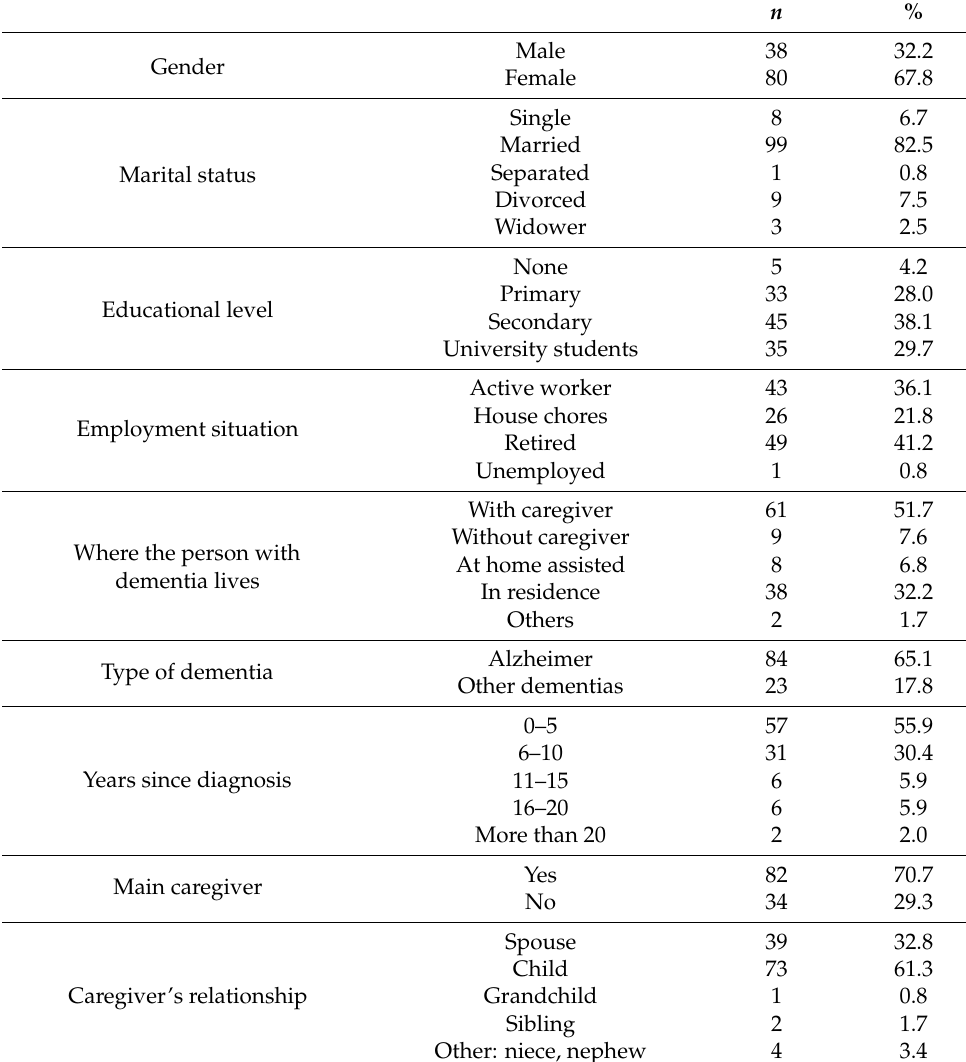
Table 1. Sociodemographic characteristics—categorial